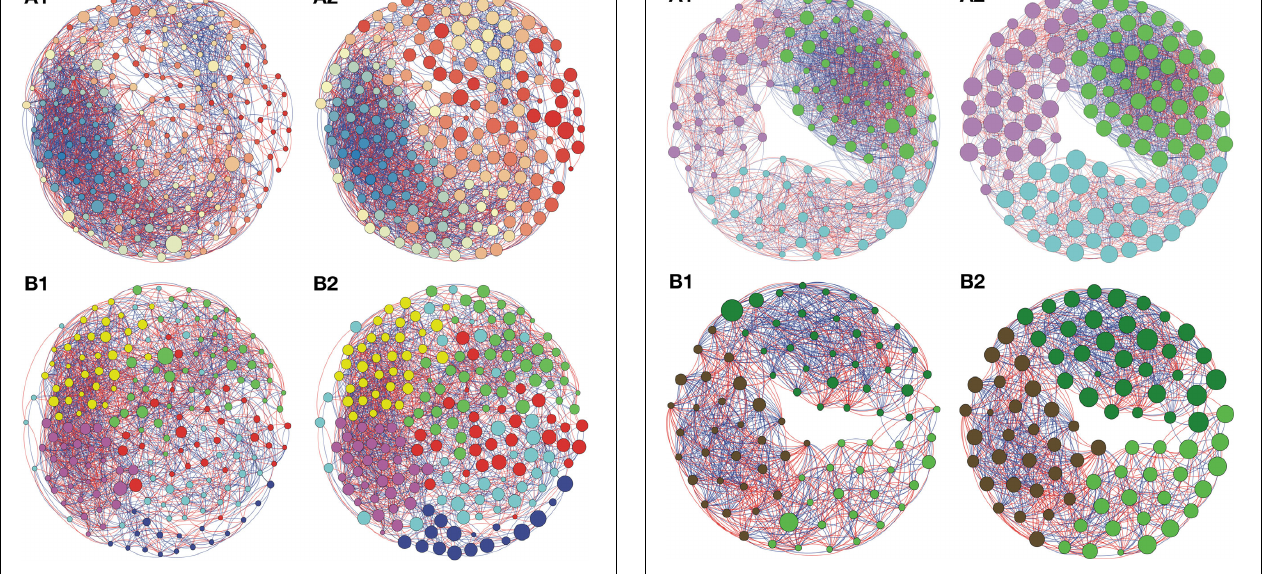
FIGURE 3 | Network interactions of soil bacterial genus found in Natural forest (A1, A2) and in the Natural pasture (B1, B2) from site B, on Pampa biome. A connection stands for a strong Pearson’s correlation ( p ≥ 0 . 9 and P -value ≤ 0.05). Each circle (usually called node) represents a bacterial genus and the sizes of the circles are proportional to the value of betweenness centrality in (A1) and (B1) . In (A2) and (B2) the sizes of the circles are proportional to value of closeness centrality. Lines connecting two bacterial genera represent the interactions between them. Blue lines represent the positive significant correlations and red lines represent a negative significant correlation. The colors of the circles represent the bacterial modules. For clarity, the OTU’s identity was omitted. Detailed networks containing the identity of each node can be observed in the Supplementary Figures S1–S5 and Supplementary Table S1.